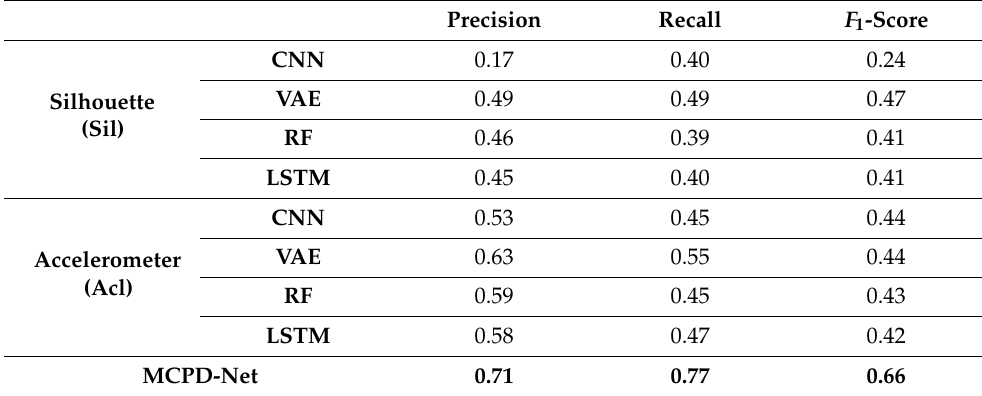
Table 1. MCPD-Net vs. unimodal architectures. Our proposed multimodal method outperforms all of the other approaches.